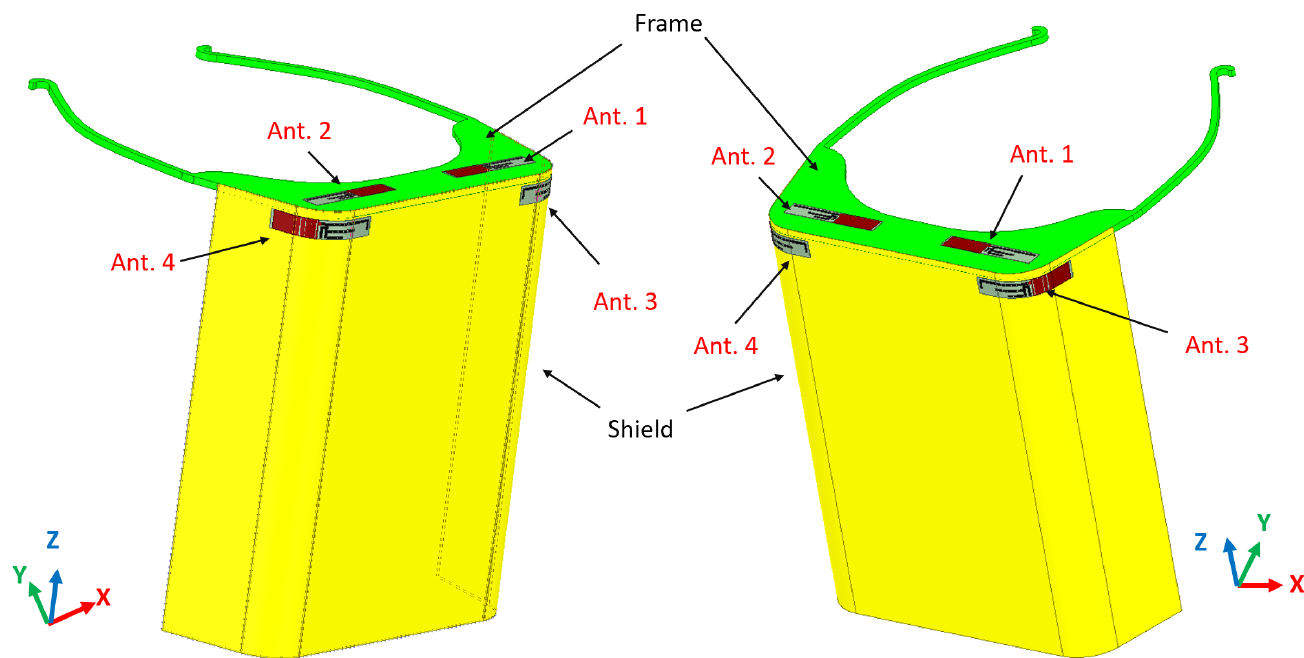
Figure 1. Schematic of the antenna system on a medical mask.